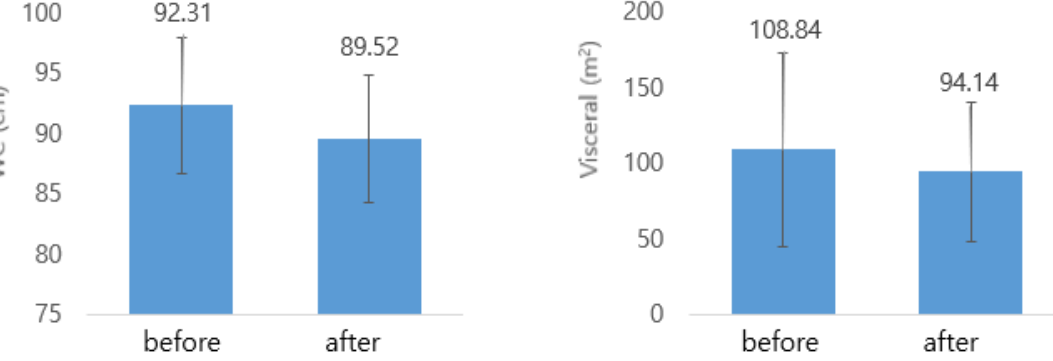
Figure 4. WC and visceral fat area before and after Kochujang treatment in the HTK group. HTK, traditional Kochujang containing a high dose of beneficial microbes; WC, waist circumference.